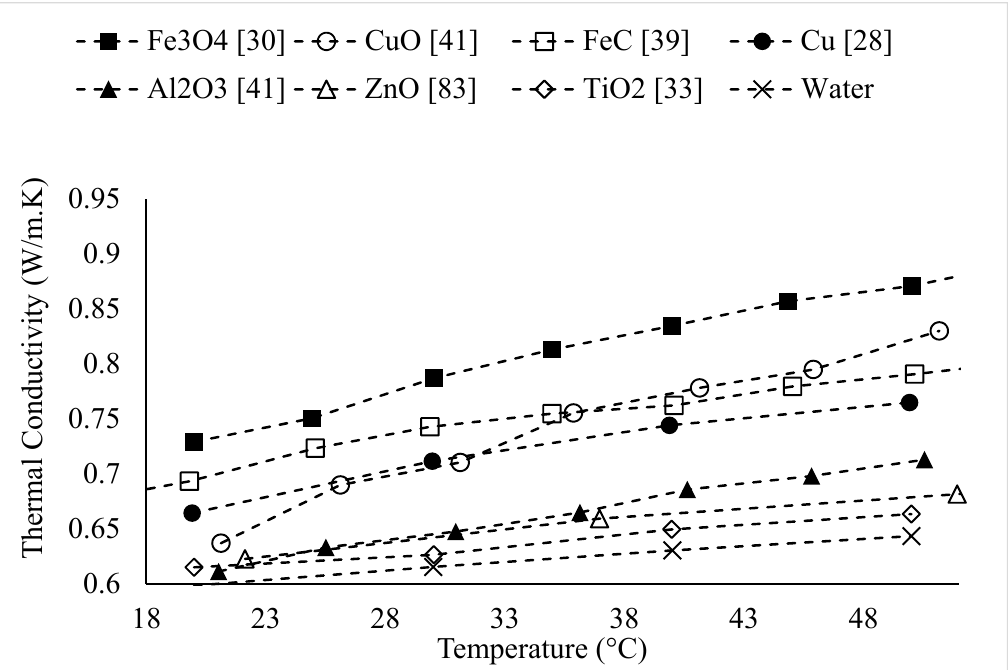
Figure 5. Variation of water-based nanofluid thermal conductivity as a function of temperature for different nanoparticles at 𝜑 = 1% .